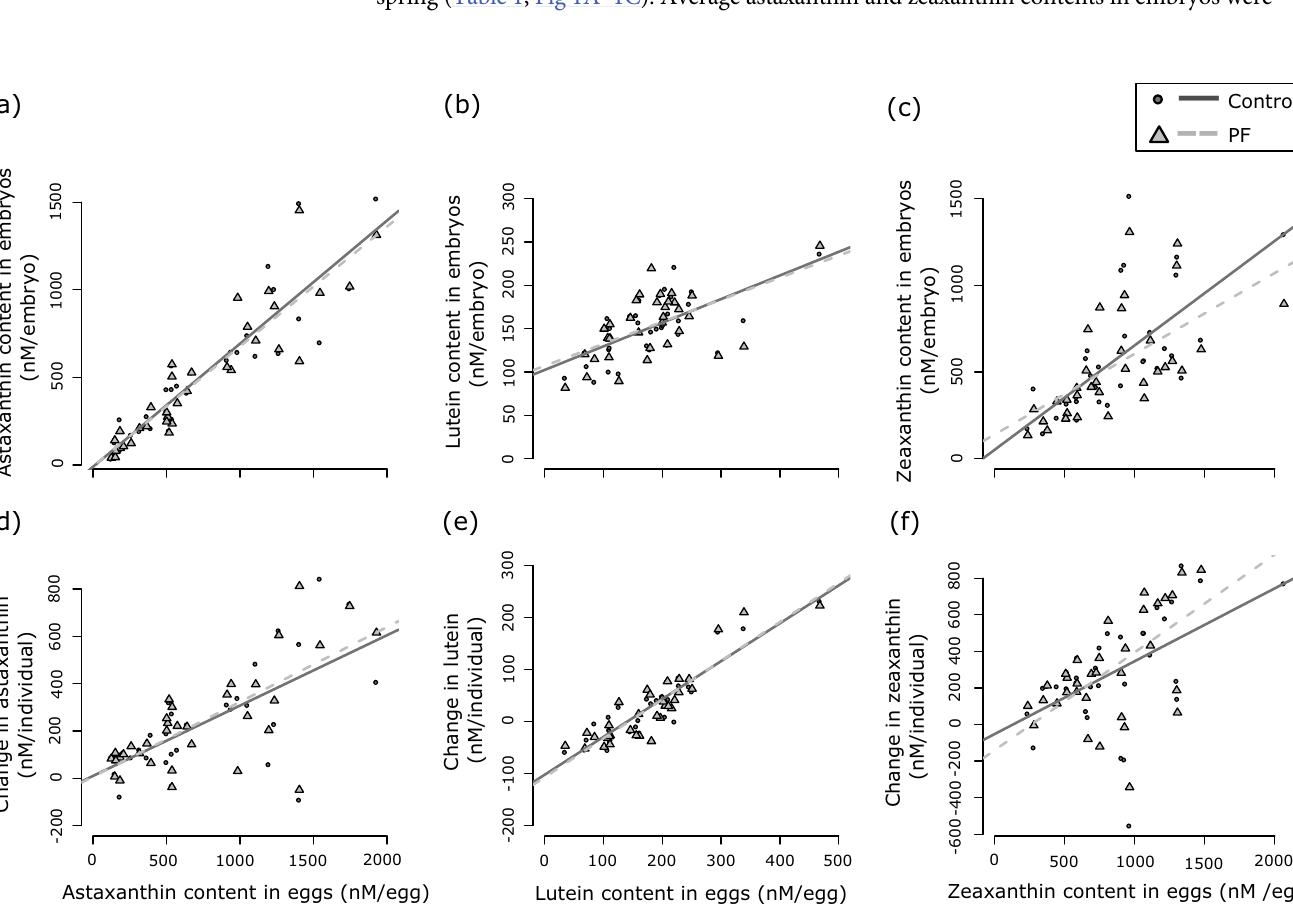
found above detection limit in any sample. Measurements of carotenoid contents for each maternal half sib family and repeatability estimates are presented in S1 Table. Measurements in eggs and embryos were significantly correlated for all carotenoids and within both environments: females that had high levels of carotenoids in their eggs before fertili- zation also showed larger amounts of carotenoids at the late-eyed development stage of their off- spring (Table 1, Fig 1A–1C). Average astaxanthin and zeaxanthin contents in embryos were